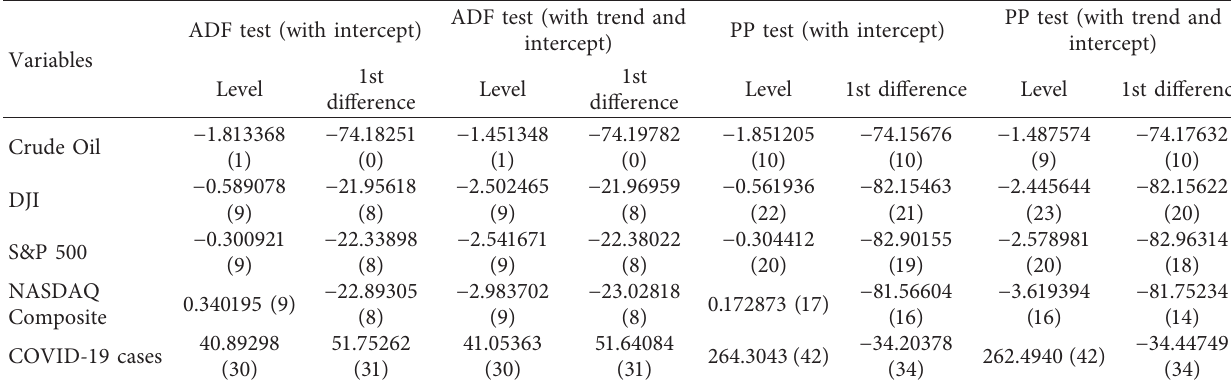
Table 2: Results of augmented Dickey–Fuller and Phillips–Perron unit root tests for each stock market index (Dow Jones Industrial Average, S&P 500, and NASDAQ Composite), Crude Oil price, and COVID-19 confirmed cases. Variables